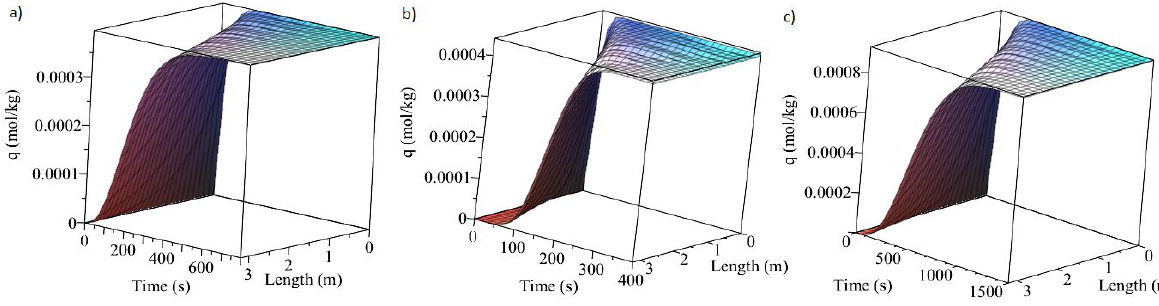
Figure 5. Loading for physisorbents: ( a ) MIL-101, ( b ) MOF-177, and ( c ) MOF-5.